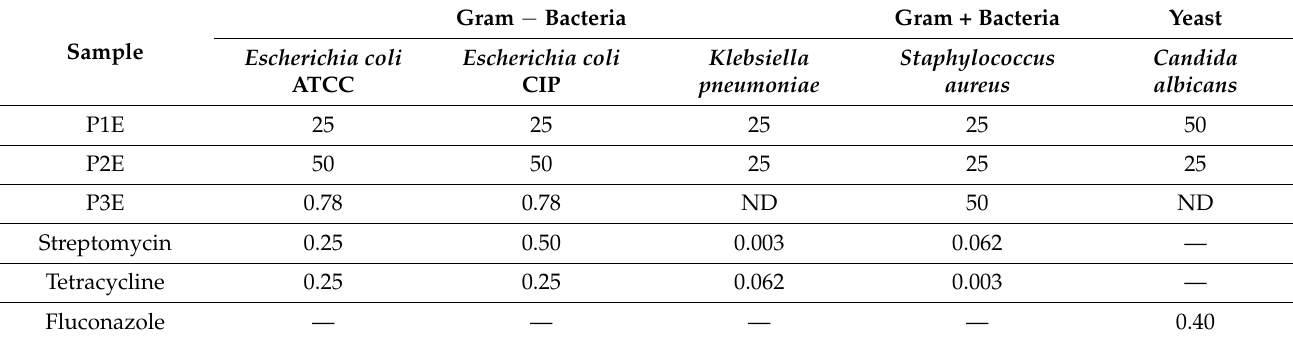
Table 2. Minimal inhibitory concentration of P. rhoeas extracts and antibiotics in